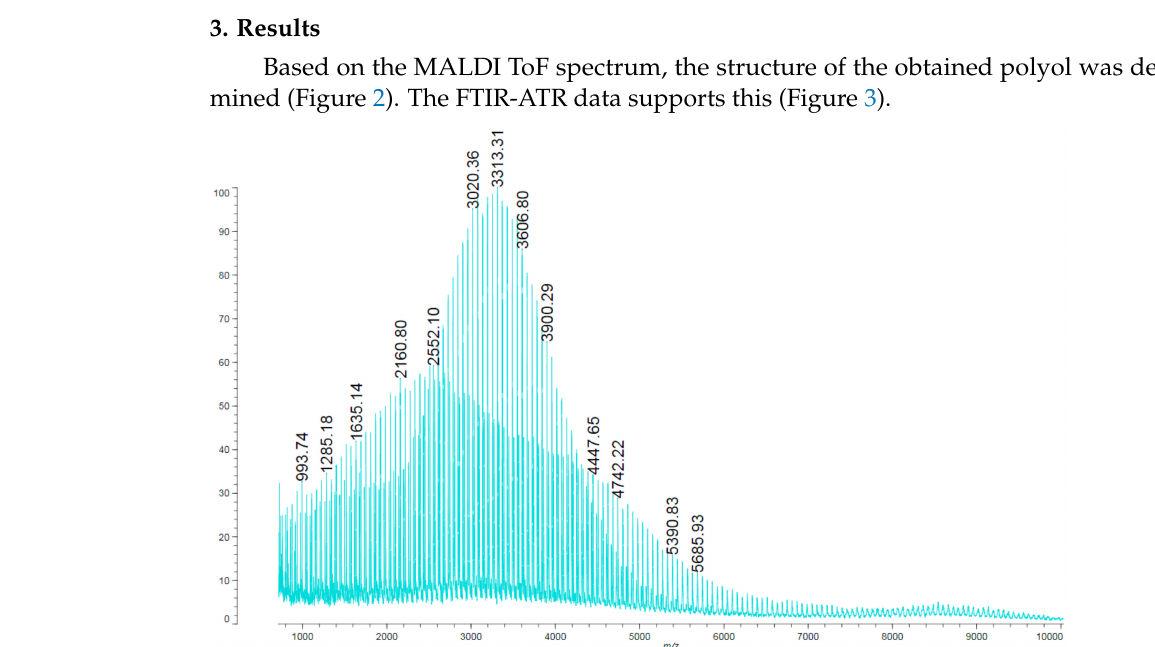
Figure 2. MALDI ToF spectra of star-shaped polyol.